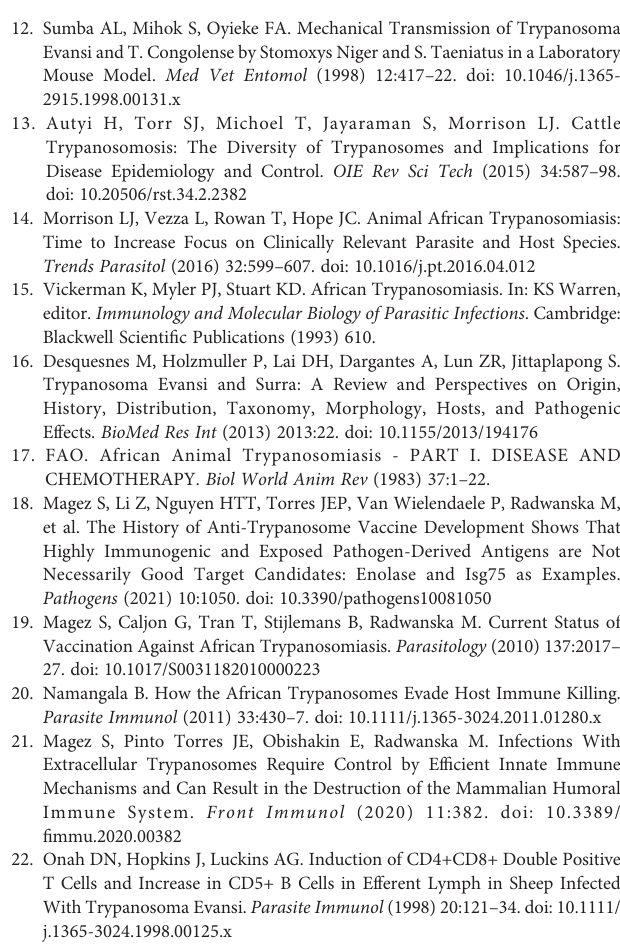
(B) Log parasite numbers where more than 25% or more of wells in 24 well plates contained motile and viable parasites at different doses. Supplementary Table 1 | Primer list for 22 genes used to con fi rm expression. Supplementary Table 2 | Gene transcripts at different times and doses post- irradiation. Supplementary Table 3 | Combined GOcirc